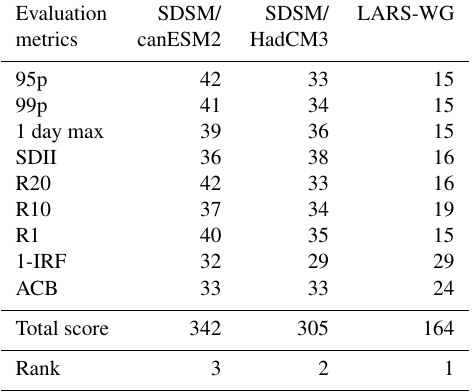
Table 6. Ranking of statistical downscaling models during the base- line period (1984–2011) for qualitative measures (distribution and extreme events of daily precipitation). The numbers in the table show the total ranking scores obtained from 15